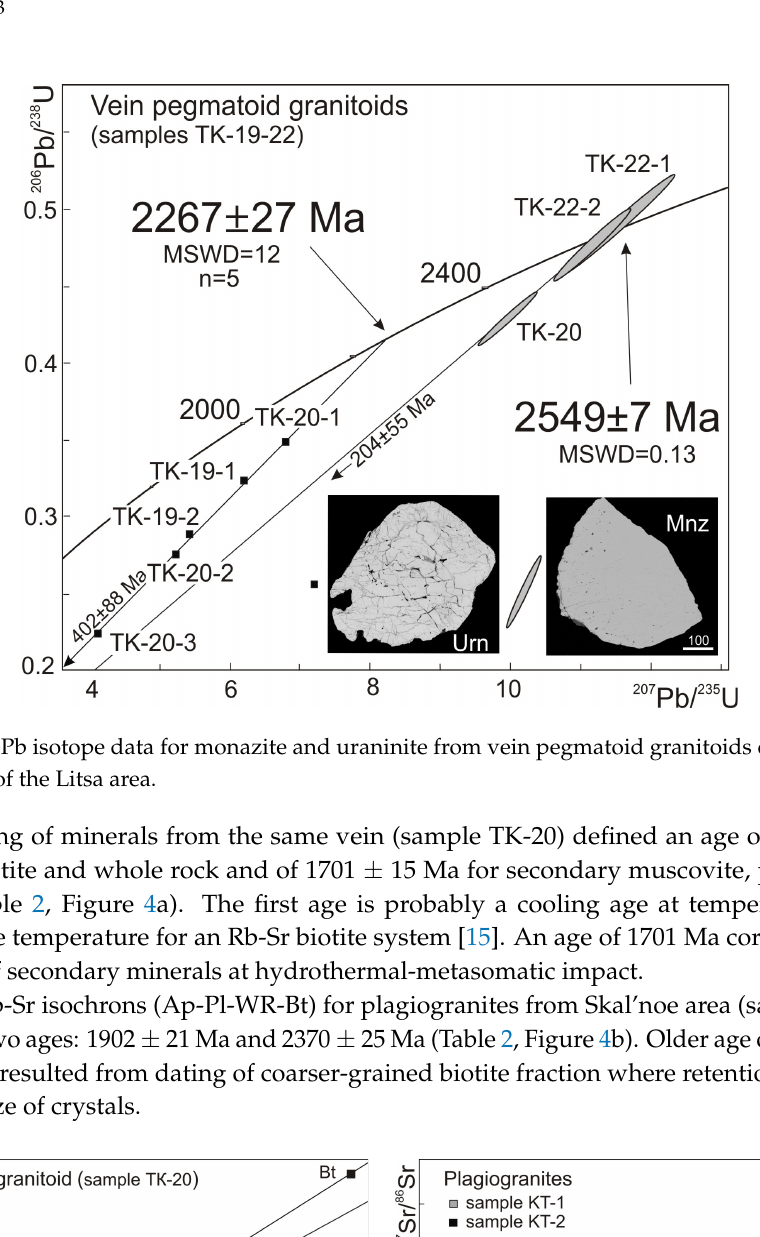
Figure 4. Rb-Sr isotope data for rocks and minerals of the Litsa area: ( a ) vein granitoid of the Dikoe ore occurrence; ( b ) plagiogranites of the Skal’noe occurrence. WR—whole rock, Pl—plagioclase, Ap—apatite, Bi—biotite, Kfs—K feldspar.